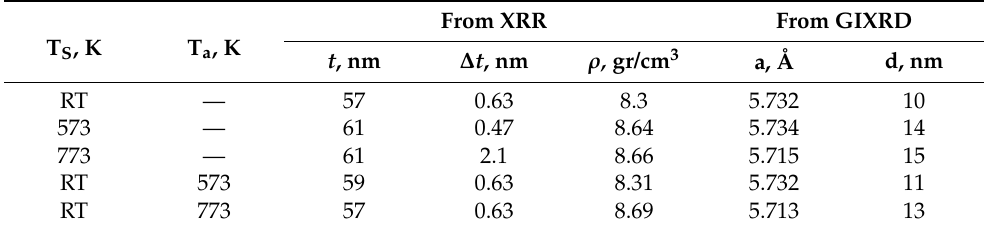
Table 1. Structural parameters obtained from XRR and GIXRD in all the samples as a function of the temperature used for deposition (T S ) and annealing (T a ). The film thickness ( t ), surface roughness ( ∆ t ) and density ( ρ ) were determined from the fits to the experimental XRR patterns with a chi-square value below 3 × 10 − 2 . The lattice parameter (a) and crystallite size (d) were calculated from GIXRD within ± 0.002 Å and ± 0.5 nm accuracy, respectively. From XRR From GIXRD T S , K T a , K t , nm ∆ t , nm ρ , gr/cm 3 a, Å d, nm RT — 57 0.63 8.3 573